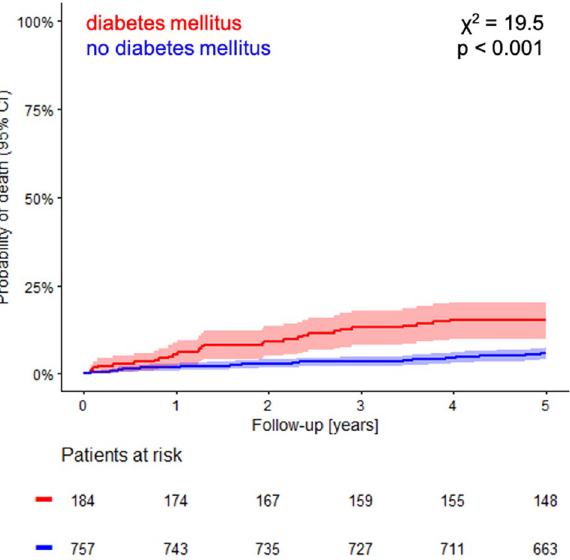
Figure 2. All-cause mortality in the subgroups of diabetic and non-diabetic patients. Kaplan–Meier curves of probability of death are shown. Numbers of patients at risk are listed below the time axis. χ 2 chi-square, 95% CI 95% confidence interval.